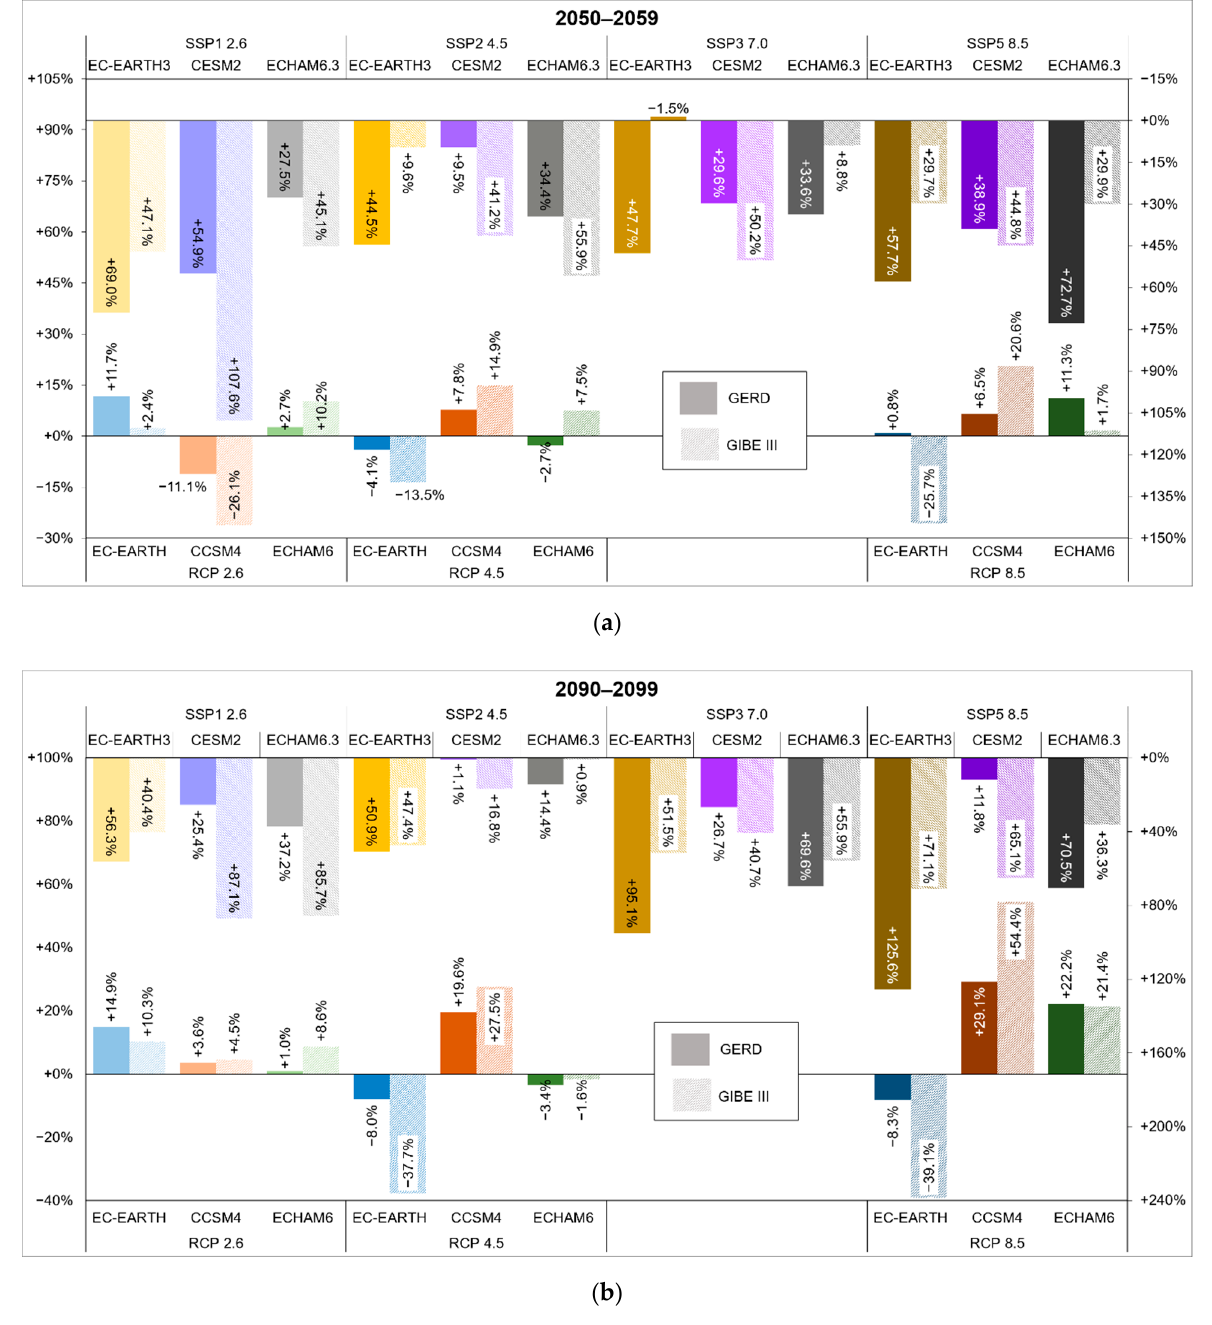
Figure 8. Yearly stream flow changes in GERD and GIBE III. ( a ) Mid Century P1. ( b ) End of Century P2.